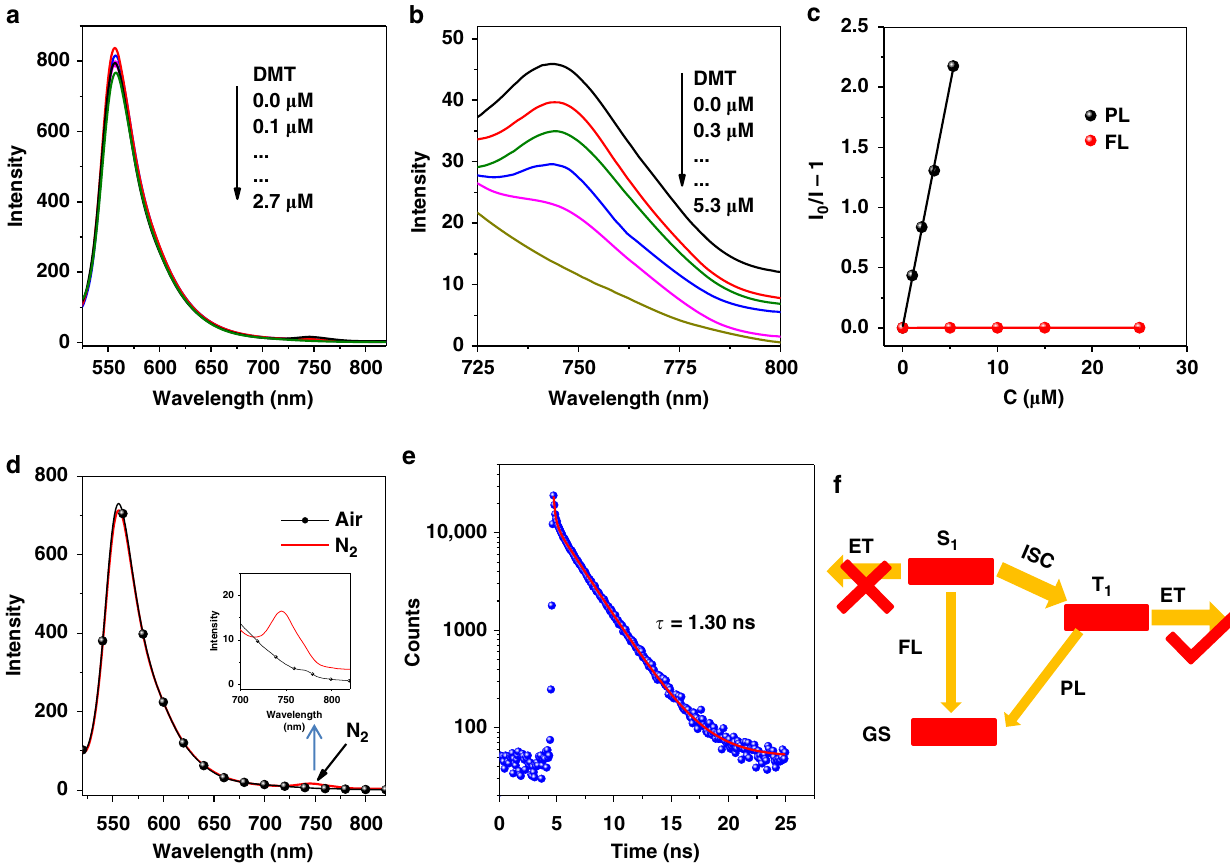
Fig. 3 Emission quenching. a Ir-3 with DMT ( λ ex = 510 nm), b zoom in the range between 725 and 800 nm, c Stern – Volmer plot of fl uorescence and phosphorescence by DMT ; d the emission of Ir-3 under nitrogen and air atmosphere; e emission lifetime of Ir-3 at 556 nm, λ ex = 510 nm, and f photophysical process of Ir-3 upon light excitation. ET electron transfer, GS ground state, ISC intersystem crossing. c PS = 5.0 μ